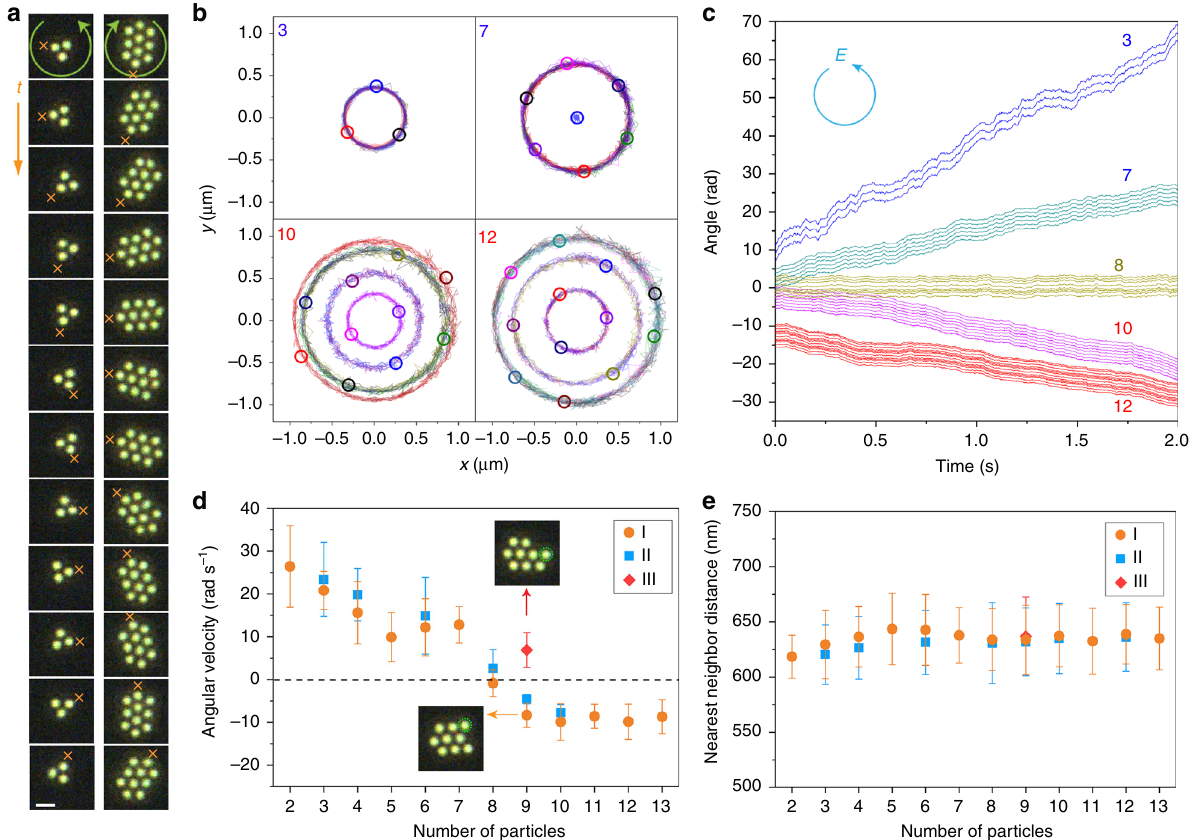
Fig. 2 Experimental determination of optical torque crossover as a function of optical matter array size. a Sequences of optical images of a 3-I array and a 10-I array in a LHCP laser beam. The time interval between frames is 0.01 s for the 3-I array and 0.033 s for the 10-I array. The two arrays clearly exhibit opposite rotation directions as indicated by following the × symbols although they are illuminated with the same LHCP optical beam. The scale bar is 1 µ m. b Trajectories of four different optical matter arrays relative to the center of mass of each array for 2 s. The open circles are representative instantaneous con fi gurations. c Time trajectories of orientations of individual NPs in each array relative to its center of mass. The central particle in the 7-I array overlaps with the center of rotation and therefore is not shown. d Average angular velocity of optical matter arrays as a function of the number of particles in each array. The colored symbols delineate type-I, II, III structures (see Fig. 1 for examples). The insets are optical images of two special arrays with 9 NPs, where the only difference is the position of one NP-indicated by the green circle. e The mean values of all nearest neighbor distances of different arrays. Error bars in d and e correspond to one standard